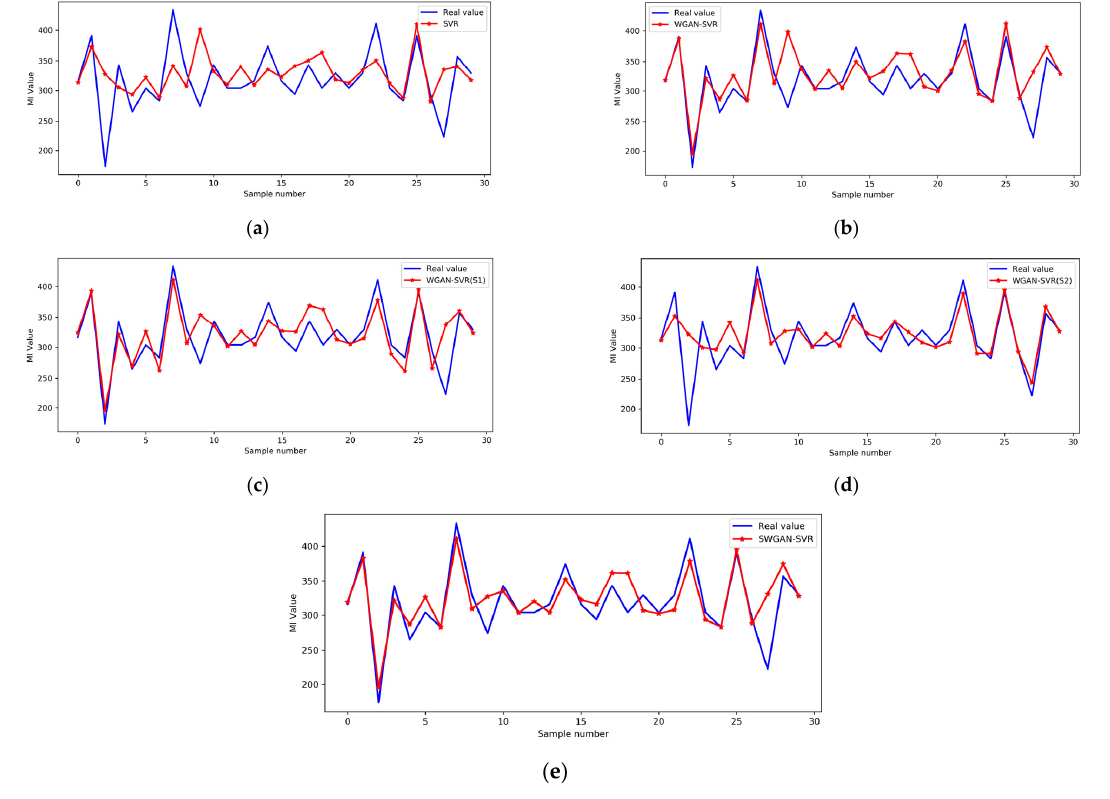
Figure 10. Assay and predicted values for the polyethylene process: (a) SVR, (b) WGAN-SVR, (c)